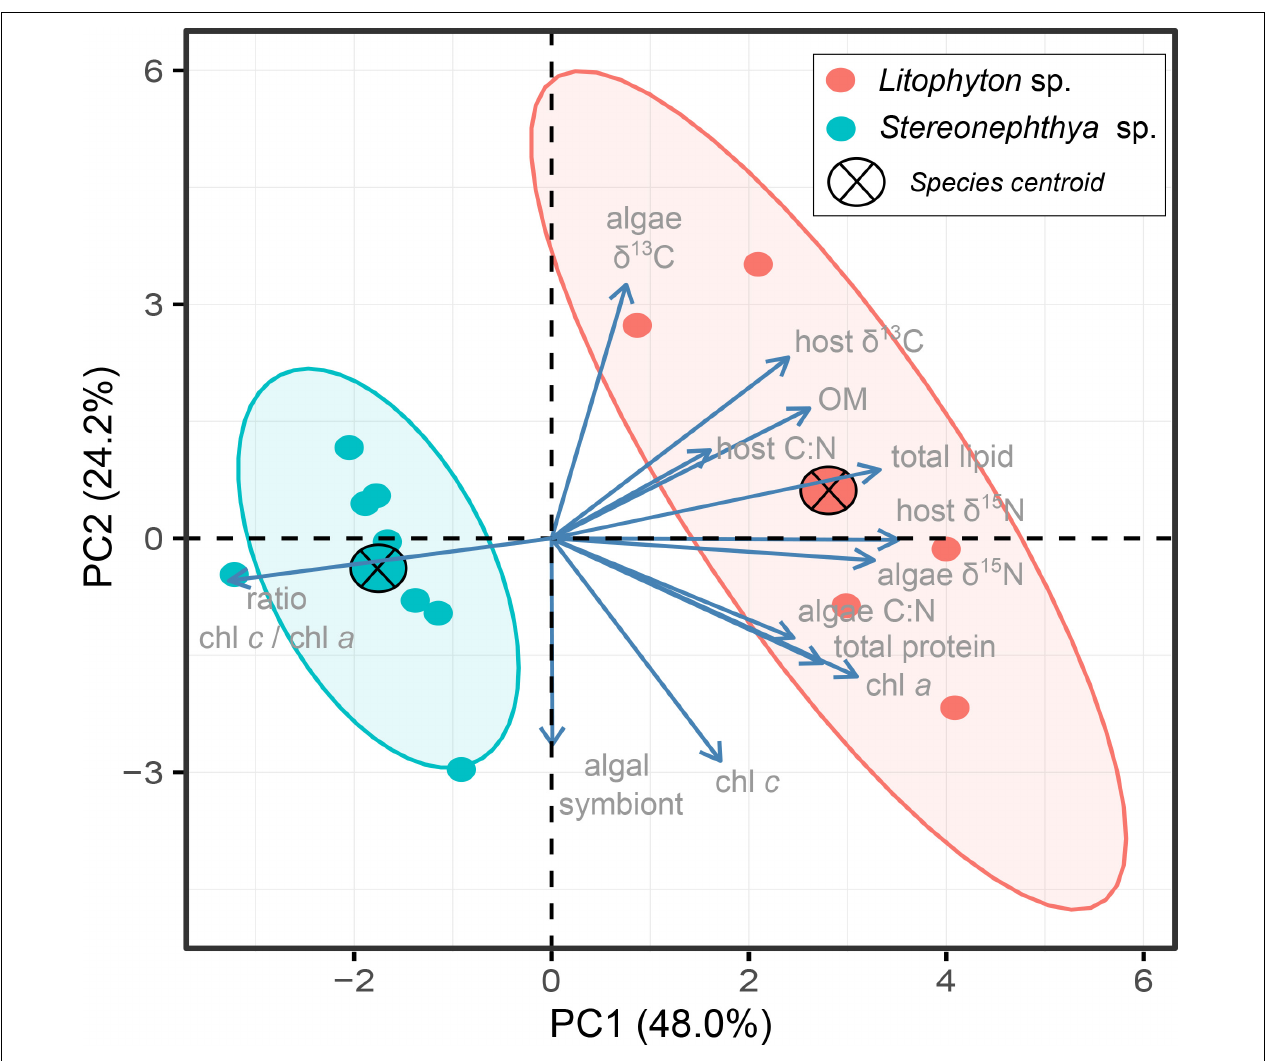
FIGURE 4 | PCA biplot displaying multivariate (trait) variation among individuals. The first two dimensions explained up to 72.2% of the variance observed. Species centroids are displayed, and ellipses are shown with an 80% confidence level for the two